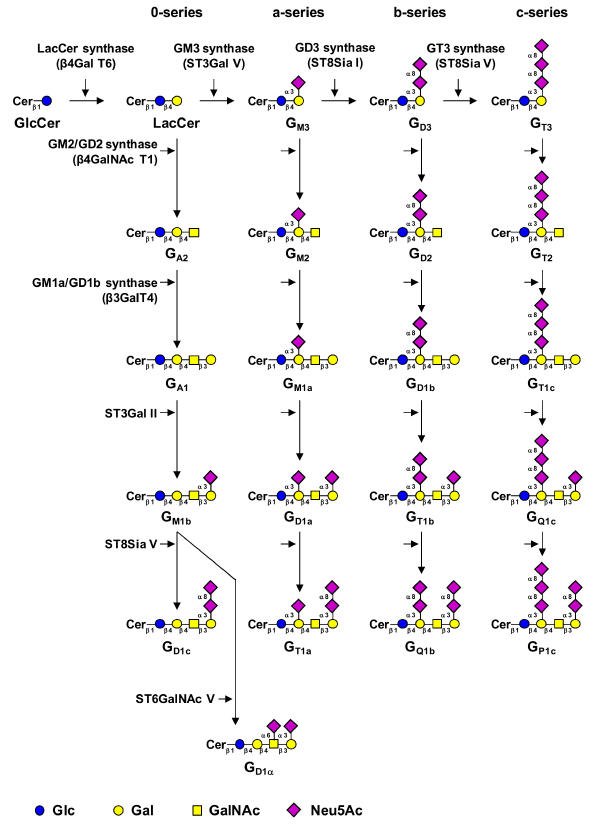
Figure 1. Biosynthesis of gangliosides. Gangliosides are classified in 4 series according to the number of sialic acid residues linked to lactosylceramide (LacCer) [10]. The 0-series gangliosides are directly synthesized from LacCer and the precursors of other series are synthesized by specific sialyltransferases: ST3Gal V (GM3 synthase), ST8Sia I (GD3 synthase) and ST8Sia V (GT3 synthase), respectively. The elongation of precursors is performed by the sequential action of N -acetylgalactosaminyltransferase ( β 4GalNAc T1), galactosyltransferase ( β 3Gal T4) and sialyltransferases (ST3Gal II and ST8Sia V). Cer, ceramide. Adapted from